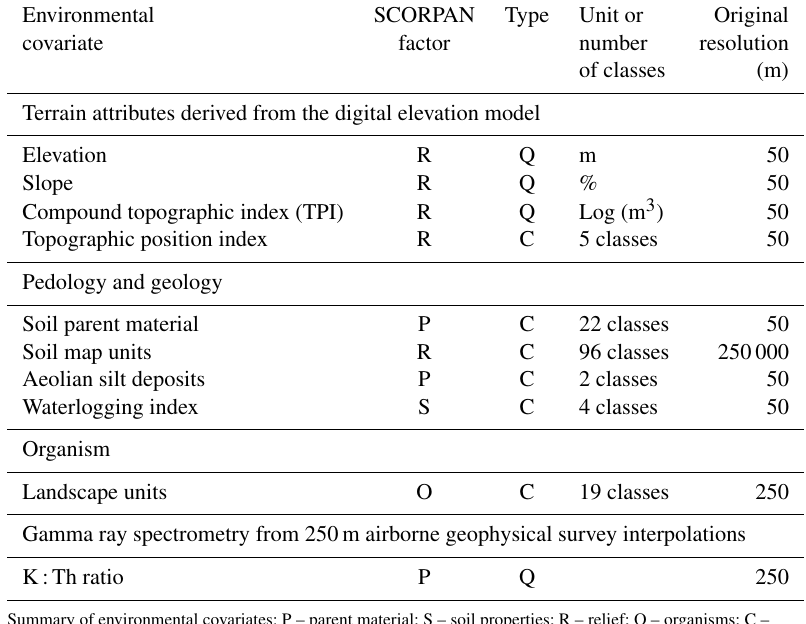
Table 1. Description of the environmental covariates selected. Environmental SCORPAN Type Unit or Original covariate factor number resolution of classes (m) Terrain attributes derived from the digital elevation model Elevation R Q m 50 Slope R Q % 50 Compound topographic index (TPI) R Q Log (m 3 ) 50 Topographic position index R C 5 classes 50 Pedology and geology Soil parent material P C 22 classes 50 Soil map units R C 96 classes 250000 Aeolian silt deposits P C 2 classes 50 Waterlogging index S C 4 classes 50 Organism Landscape units O C 19 classes